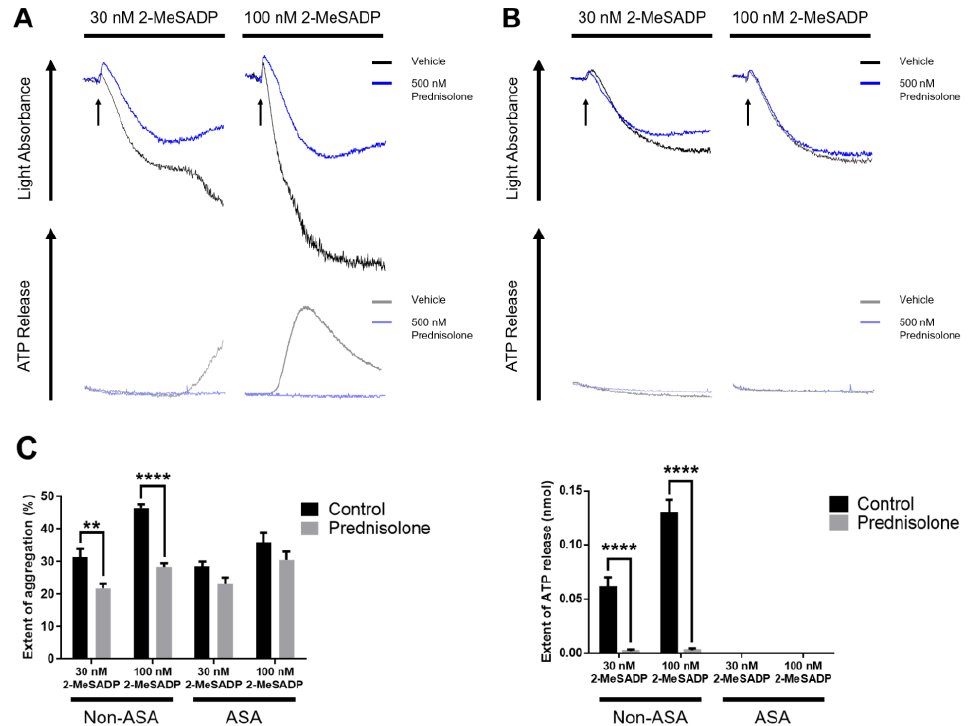
Figure 2. The effect of prednisolone on 2-MeSADP-induced platelet aggregation and secretion in aspirinated platelets. ( A ) Non-aspirinated and ( B ) aspirinated washed platelets were stimulated with 30 nM and 100 nM 2-MeSADP in the presence or absence of 500 nM prednisolone and platelet aggregation and secretion were measured. The entire set of data represents three separate experiments ( n = 6). ( C ) The extent of aggregation and dense granule secretion were quantified from panels A and B. Data are shown as mean ± SE. **, p < 0.01; ****, p < 0.0001.